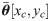
Example of a 9 × 9 interaction map of a V1 area centered on neurons strongly responding to a central preferred orientation of 45°, and colored with the relative response w.r.t. no feedback.The feedback strength is set to 1 and the SDPC is trained on natural images. At each location identified by the coordinates (xc, yc) the angle is θ¯[xc,yc] (see Eq 11) and the color scale is proportional to ra(kFB) (see Eq 25). The color scale being saturated toward both maximum and minimum activity, all the activities above 1.3 or below 0.5 have the same color, respectively dark green or purple.